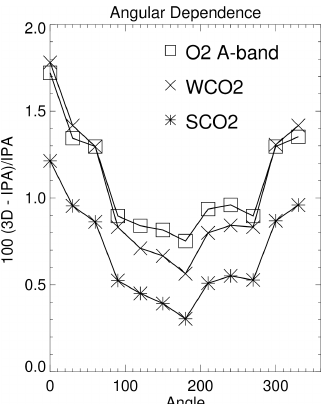
Figure 3. The angular dependence of the SHDOM 100 (3D- IPA) / IPA radiative perturbations for glint-viewing geometry for observation footprints along a circle of 4km surrounding an iso- lated cloud. The observation footprints are to the west, north, east, and south of the cloud at angles of 0, 90, 180, and 270 ◦ . The sun is along the − x axis and the sensor is along the + x